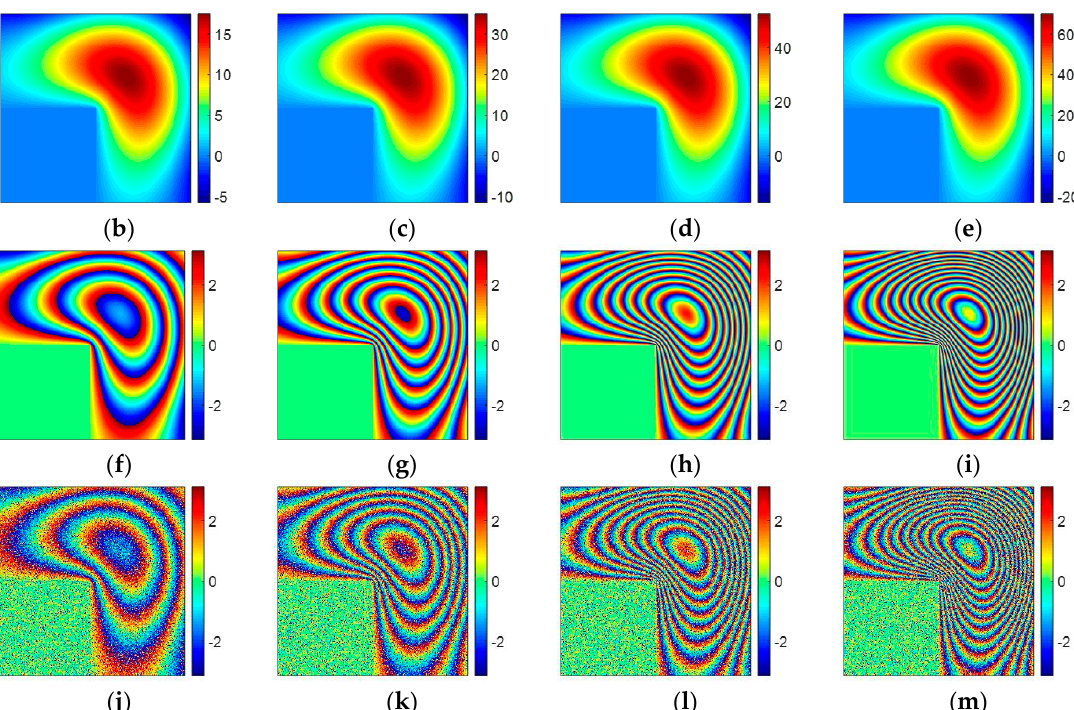
Figure 9. ( a ) The examples of simulated terrain obtained by the function membrane in 3D space. ( b – e ) reference unwrapped phase with four di ff erent d s (( b ) d 1 = 17.5, ( c ) d 2 = 35.0, ( d ) d 3 = 52.5, ( e ) d 4 = 70.0, and unit is radian). ( f – i ) The simulated noise-free wrapped phases of ( b – e ). ( j – m ) The simulated wrapped phases of ( b – e ) with mean coherence coe ffi cient 0.75.